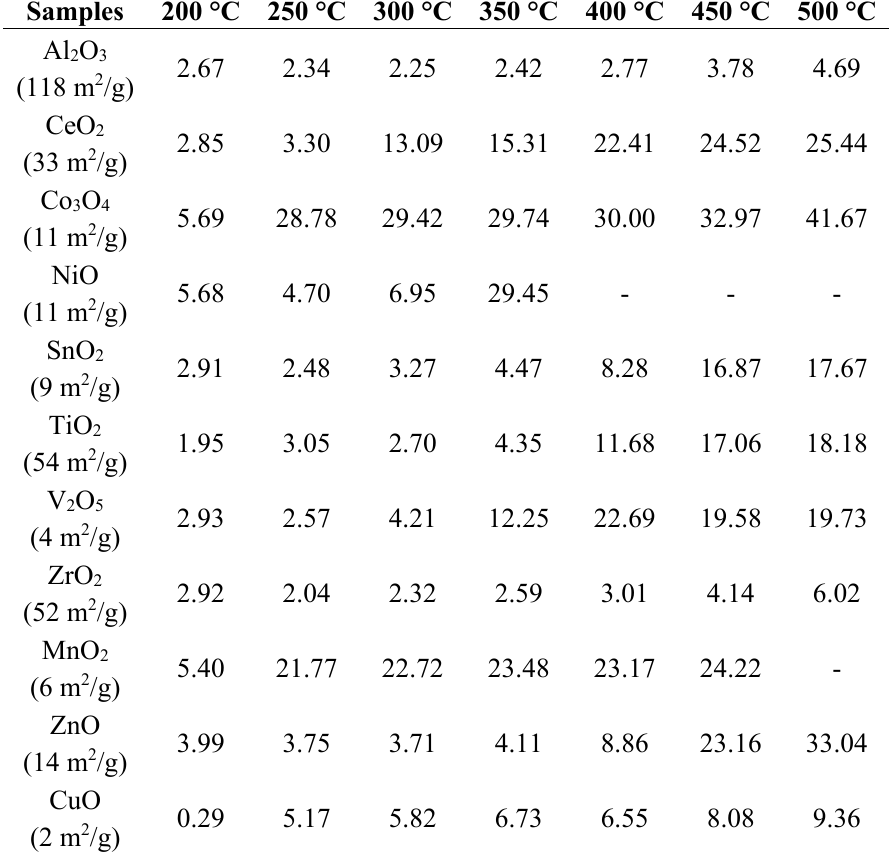
Table 1. Propylene conversion (%) of several oxides at different reaction temperatures.